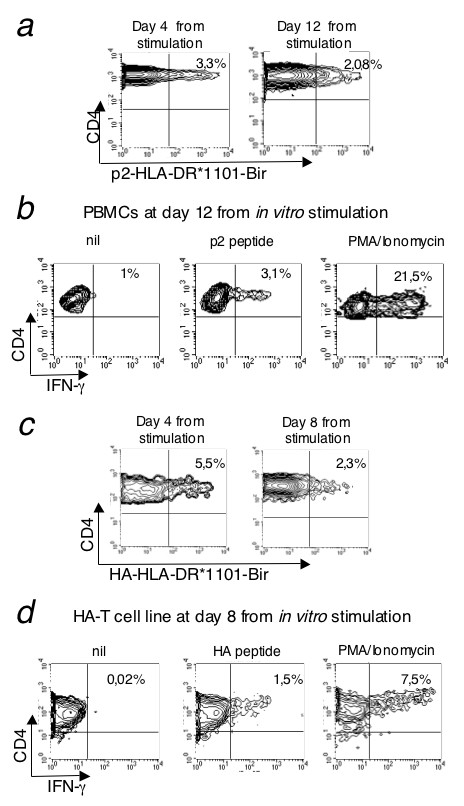
Peptide-loaded HLADR1101-Bir tetramers stain polyclonal T cells specific for p2 and HA. In vitro expanded T cells were stained with HLA-DR*1101-Bir tetramers loaded with either p2 or HA peptides. (a) Staining of PBMCs from a HLA-DR*1101 healthy donor after one round of in vitro stimulation with 5 μM of p2-peptide and 40 u/ml of IL-2. (b) Intracellular production of IFN-γ by T cells contained in the p2-enriched PBMC. T cells were stimulated for 6 hours with p2 in the presence of HLA-DR*1101+ LCL cells at 37°C. Brefeldin A was added after the first hour of stimulation. The cells were then fixed, permeabilised and stained with anti-IFN-γ mAb. Cells unstimulated (nil) and stimulated policlonally with PMA-Ionomycin (PMA/ionomycin) are shown as controls. Numbers in quadrants indicate the percentage of T cells stained with anti-IFN-γ mAb (c) Staining of PBMCs from HLA-DR*1101 healthy donor with HA-loaded HLA-DR*1101-Bir tetramers. T cells were after three rounds of in vitro stimulation with 1 μg/ml of HA peptide and 40 u/ml of IL-2. The staining is performed at the indicated days after the third stimulation. Numbers in quadrants indicate the percentage of T cells stained by HLA-DR tetramers. (d) Intracellular production of IFN-γ by CD4+ T cells contained in the HA-specific T cell line at day 8 from the third in vitro stimulation. Activation and staining of CD4+ T cells was performed as described in (b).